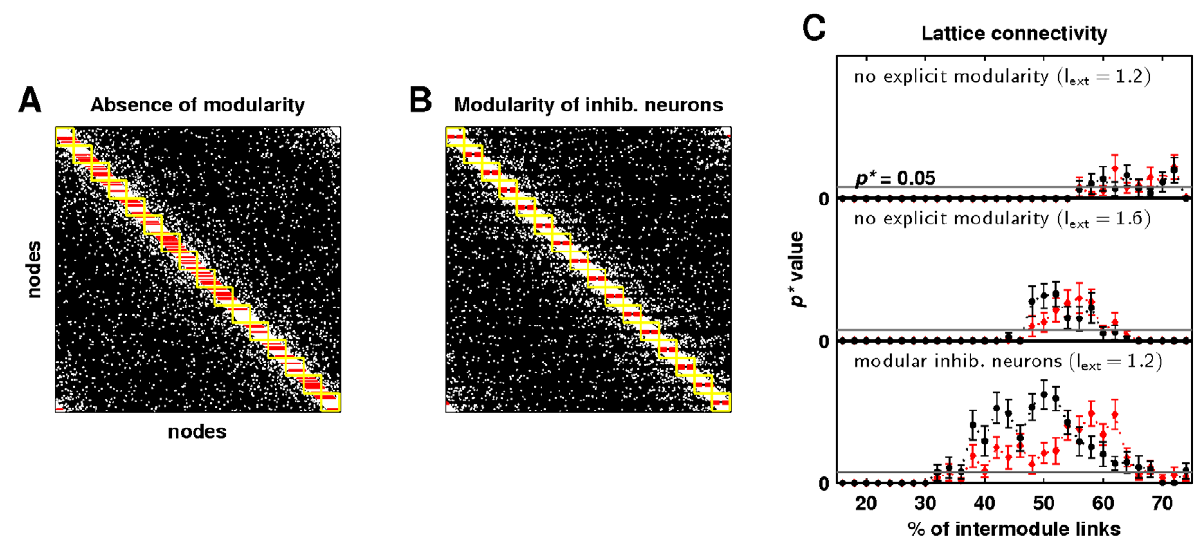
Figure 8. Role of modularity and low wiring cost in emergence of self-organized critical network dynamics. (a) An illustrative lattice connectivity matrix with the optimal power-law ( a ~ 8 = 3 ) density scaling function. Presumed network modules are shown in yellow, while inhibitory synapses are shown in red. Note the presence of significant numbers of intermodule inhibitory synapses. (b) A variant of the connectivity matrix in (a), with modularity of inhibitory neurons. (c) Statistical significance of power-law distributions of avalanche sizes (black) and durations (red) for the lattice (top), the lattice with restored module spike rate (center), and the modified lattice, in which inhibitory neurons were arranged into explicit modules. Gray lines show the p (cid:3) ~ 0 : 05 threshold for power-law scaling. Error bars represent the standard error of the mean from 20